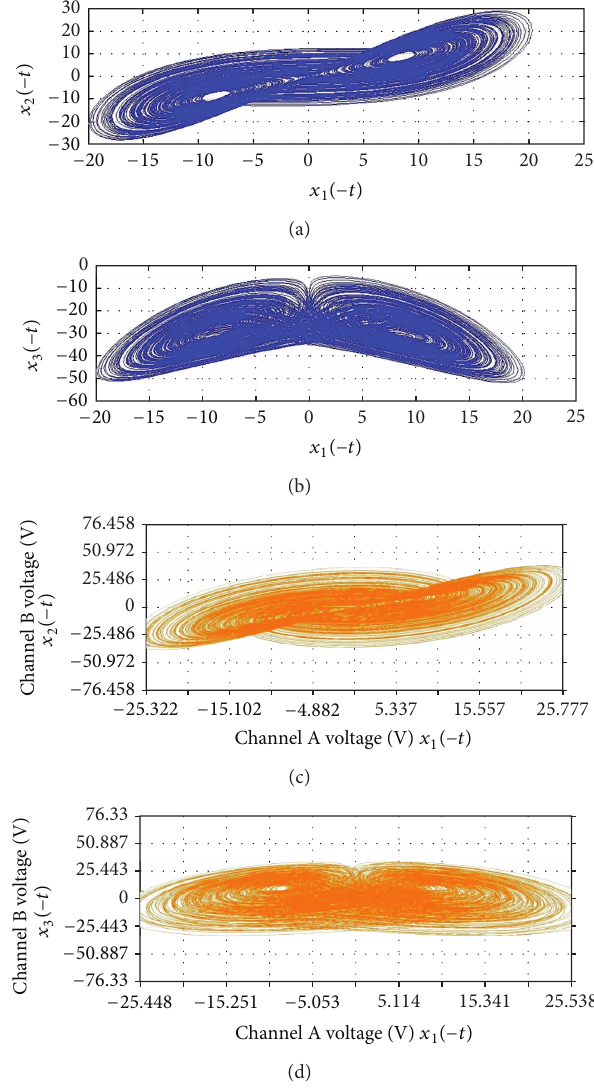
Figure 3: Projection of phase portraits outputs in electronic circuit for time-reversed Lorenz